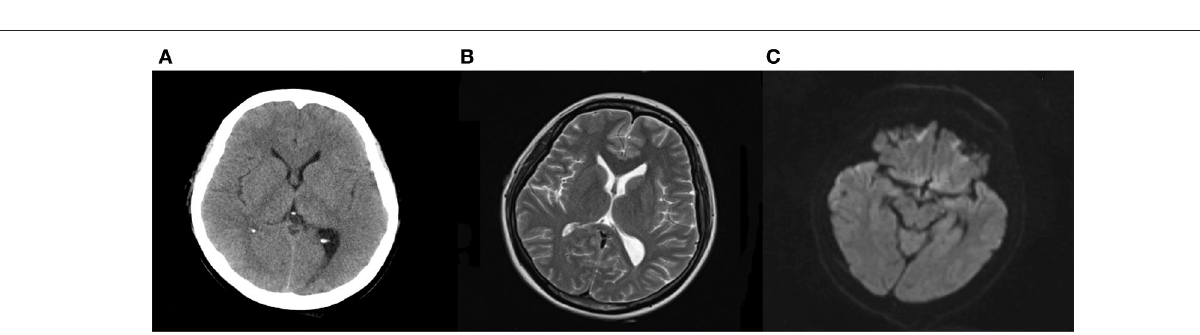
FIGURE 4 | Computed tomography (A) and magnetic resonance imaging (B,C) after treatments. Computed tomography suggested the edema was disappeared, and the subarachnoid hemorrhage was absorbed after treatments. Magnetic resonance imaging found T2 hypersignal was disappeared, and the DWI signal without hypersignal